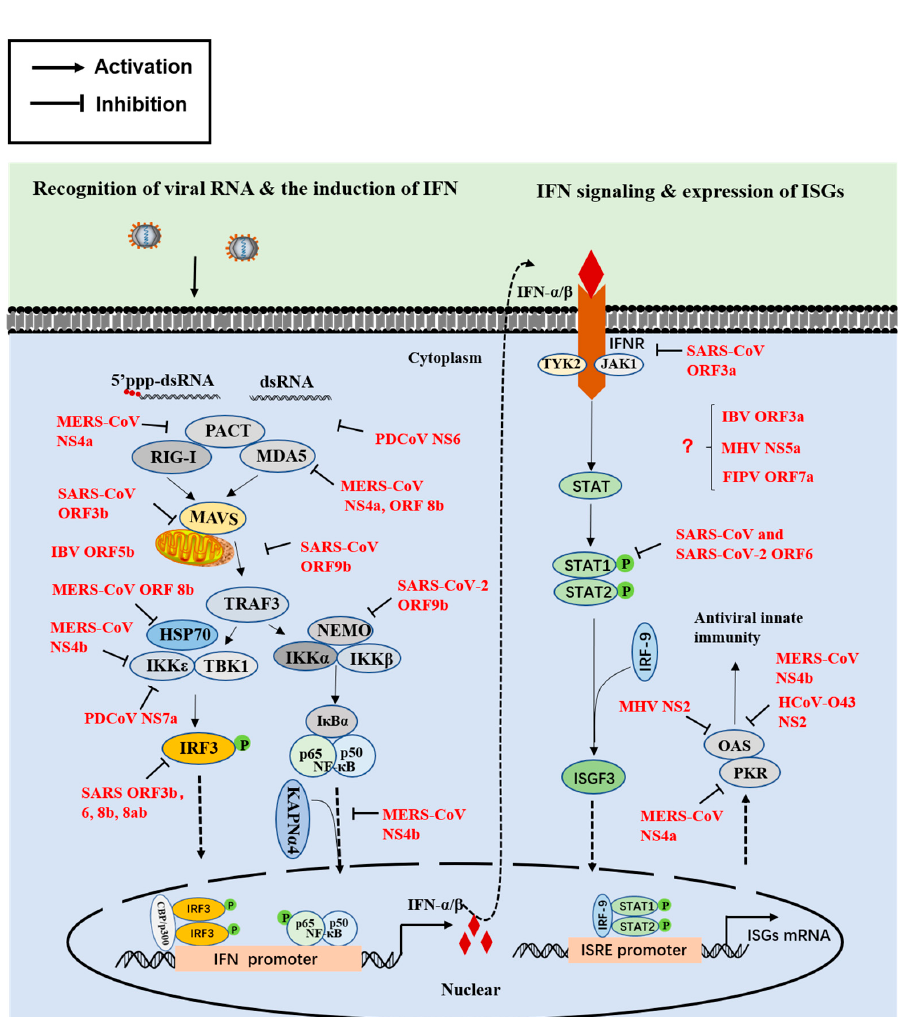
Figure 2. Regulation of innate immune interferon responses by coronavirus accessory proteins. Schematic diagram representing the induction and signaling transduction of type I interferon during coronavirus infection and the known modulatory mechanisms of accessory proteins. PRRs (RIG-I and MDA5) are activated to trigger a series of signaling pathway activations, such as IRF3 and NF- κ B, for the induction of IFN. IFNs then bind to IFNAR and activate the JAK-STAT signaling pathway to trigger ISGs. Coronavirus accessory proteins regulating the pathway are shown in red. A question mark indicates the unknown IFN antagonistic mechanism. Abbreviations: dsRNA, double-stranded RNA; PACT, protein activator of protein kinase R; RIG-I, retinoic acid-inducible gene I; MDA5, melanoma differentiation-associated gene 5; MAVS, mitochondrial antiviral signaling protein; TRAF3, TNF receptor-associated factor 3; HSP70, heat shock protein 70; TBK1, TANK- binding kinase 1; IKK ε , inhibitor of κ B kinase ε ; IRF3, interferon regulatory factor 3; NEMO, NF- κ B essential modulator; IKK α , inhibitor of κ B kinase α ; IKK β , inhibitor of κ B kinase β ; I κ B α , inhibitor of nuclear factor kappa-B; NF- κ B, nuclear factor kappa-B; KAPN- α 4, karyopherin- α 4; TYK2, tyrosine kinase 2; JAK1, Janus kinase 1; STAT1/2, signal transducer and activator of transcription 1/2; IRF9, interferon regulatory factor 9; ISGF3, IFN-stimulated gene factor 3; OAS, oligoadenylate synthetase; PKR, protein kinase R; ISRE, IFN-stimulated response element; P, phosphate.